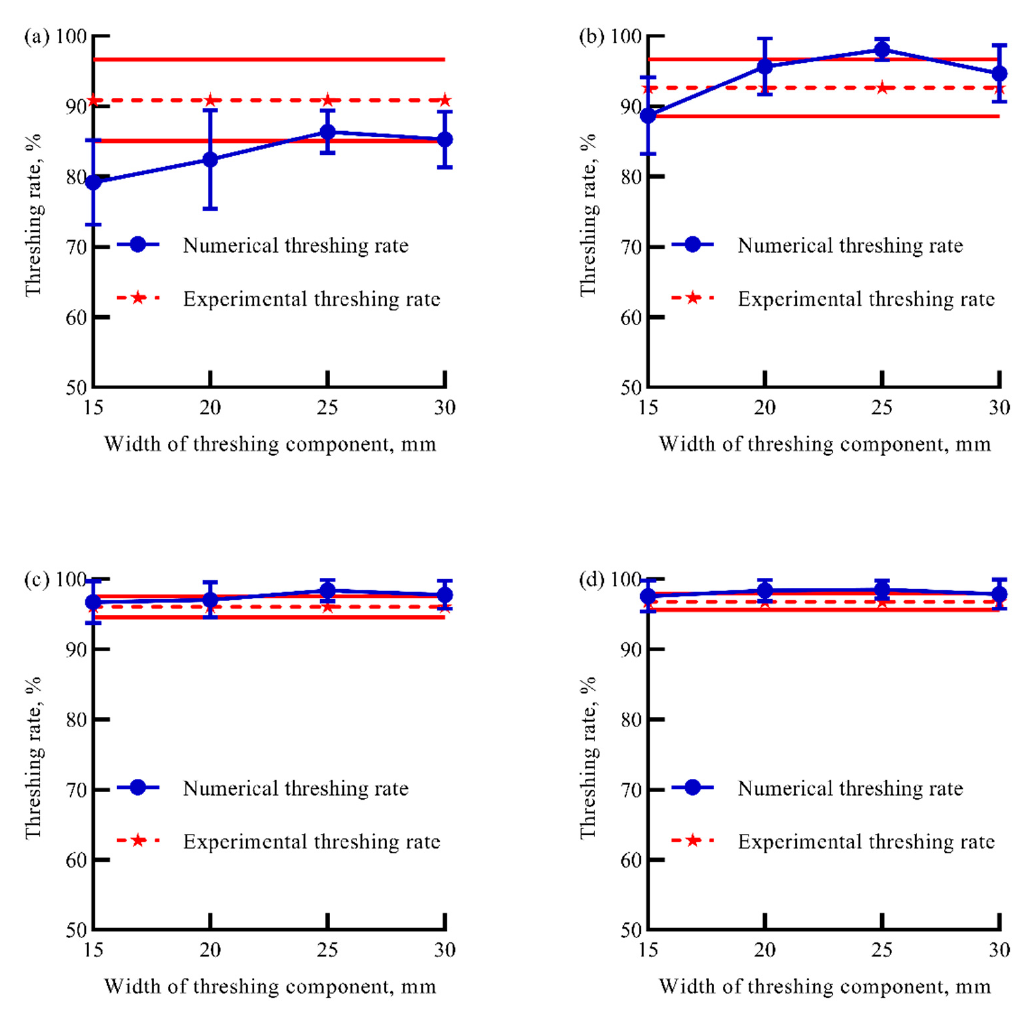
Figure 5. Effects of the width of threshing component on the simulation results of threshing rate at the drum rotation rate of ( a ) 122.70 rpm, ( b ) 187.15 rpm, ( c ) 252.10 rpm and ( d ) 317.15 rpm.